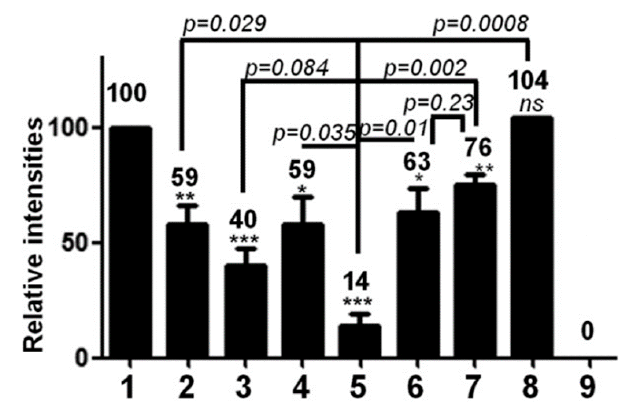
Figure 6. Not all S or T phospho-acceptors are phosphorylated at the same time. This histogram represents the relative intensities of phosphorylated HBc and HBc derivatives. Huh7 cells were